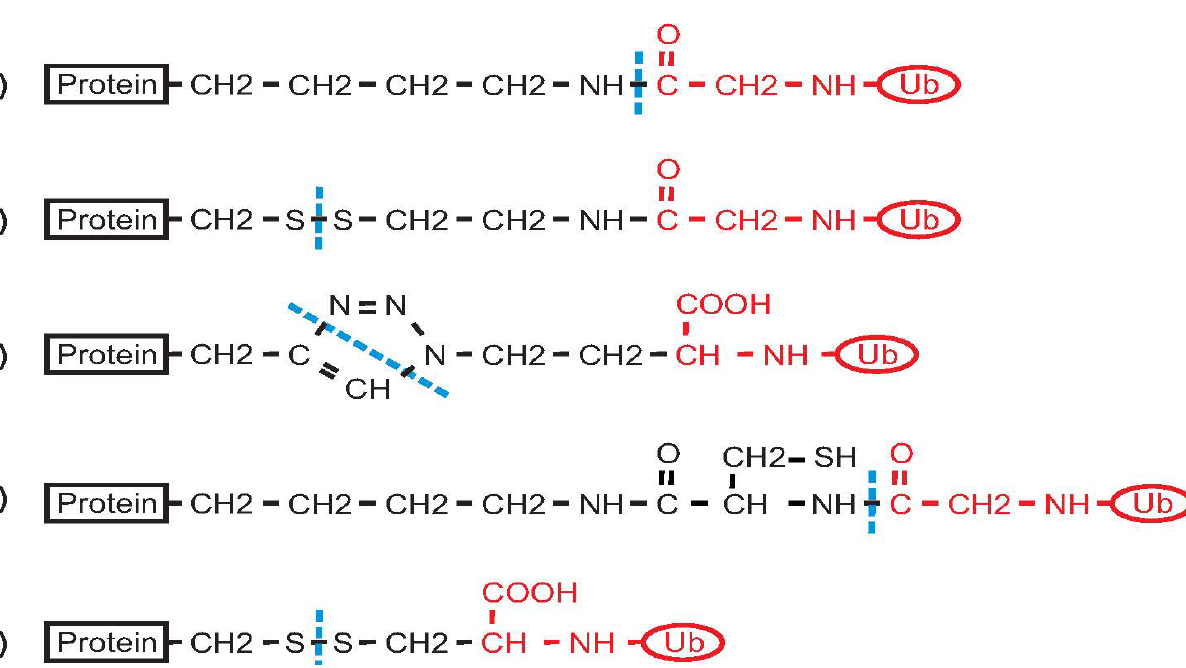
Figure 2. Summary of the different types of covalent bonds that result from different approaches for protein ubiquitination. (1) Native isopeptide bond; (2) Product of disulphide directed ligation; (3) Product of azide-alkyne cycloaddition; (4) Product of ligation using a genetically encoded D -cysteine- ε -lysine; (5) Simple disulphide ligation (protein and Ub precursors are functionalized by introduction of two cysteine residues). Black indicates the protein and the reactive linker. The Ub moiety is shown in red. A dashed blue line indicates the site(s) of covalent bond formation between the protein and